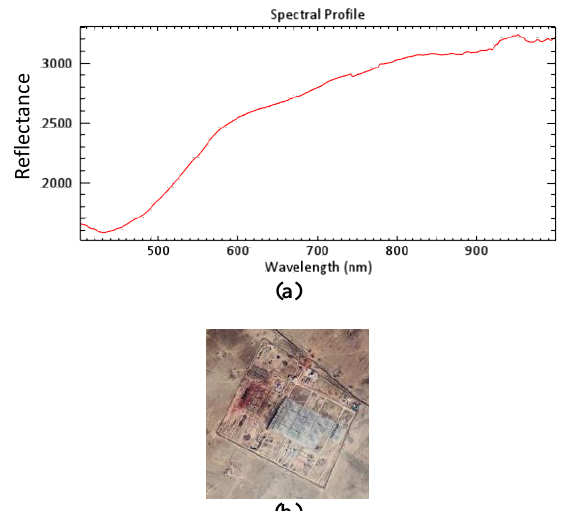
Figure 12: (a) Spectral signature of electrical substation, (b) reference HR image of the location.